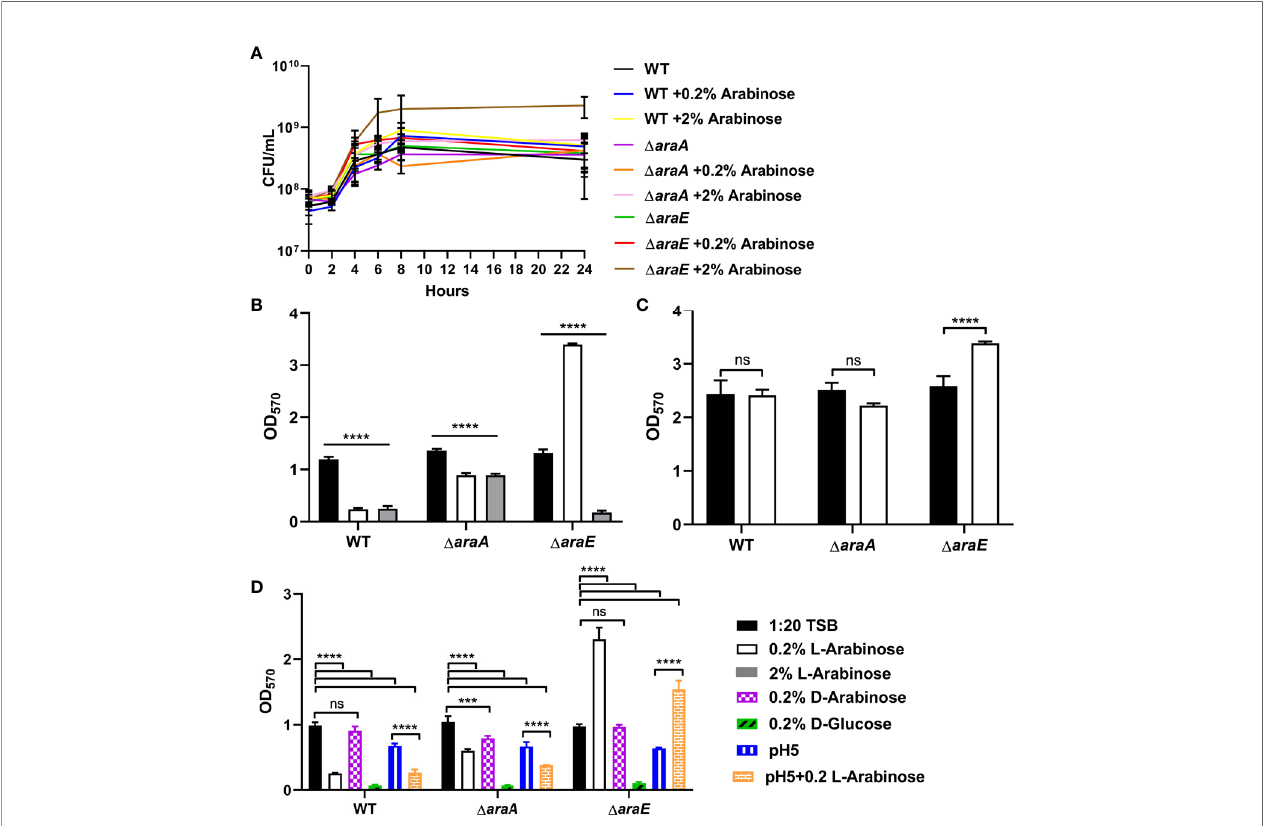
FIGURE 3 | L-arabinose effects bio fi lm formation at low or high concentrations but does not induce dispersal. (A) WT 14028, D araA and D araE strains were grown in 5 mL tubes in 4 mL 1:20 TSB with or without 0.2% or 2% L-arabinose. Aliquots were removed at designated time points and plated for colony forming units (CFU). (B) WT 14028, D araA and D araE strains were grown in 96-well plates in 100 µL 1:20 TSB (black bars) or 1:20 TSB with 0.2% (white bars) or 2% L-arabinose (gray bars). After 24 hours, planktonic cells were removed, then bio fi lms were washed, heat fi xed, and stained with crystal violet (CV) for relative bio fi lm measurement as determined at OD 570 . (C) WT 14028, D araA and D araE strains were grown in 96-well plates in 100 µL 1:20 TSB. After 24 hours media was replenished with more 1:20 TSB (black bars) or 1:20 TSB with 0.2% L-arabinose and allowed to grow another 24 hours before staining with CV. (D) WT 14028, D araA and D araE strains were grown in 96-well plates in 100 µL 1:20 TSB (black bars), 1:20 TSB with 0.2% (white bars), 0.2% D-arabinose (purple bars), 0.2% D-glucose (green bars), pH5 (blue bars), or pH 5 with 0.2% L-arabinose (orange bars). Data are mean ± SD, statistical analyses were done using a two-way ANOVA with Dunnett ’ s multiple comparisons test NS, not signi fi cant ( P >0.05); *** P <0.001; **** P